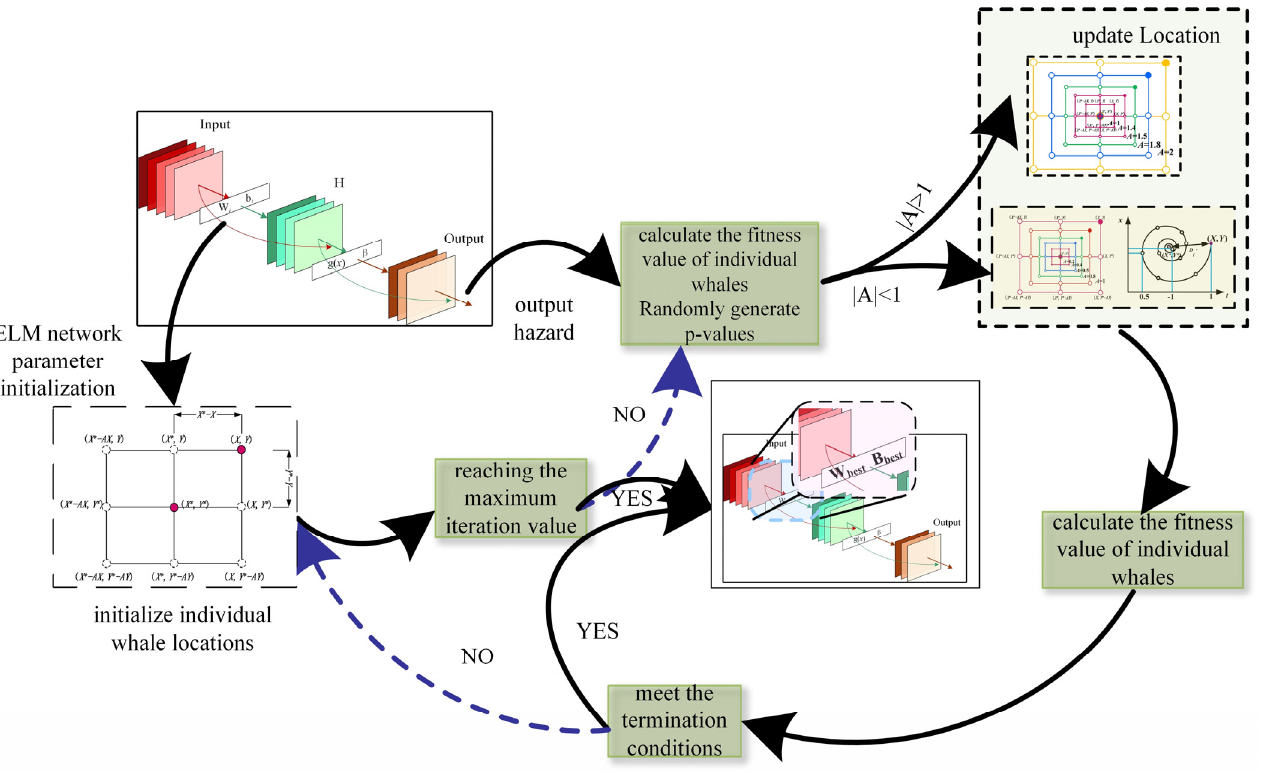
Figure 3. WOA-ELM model